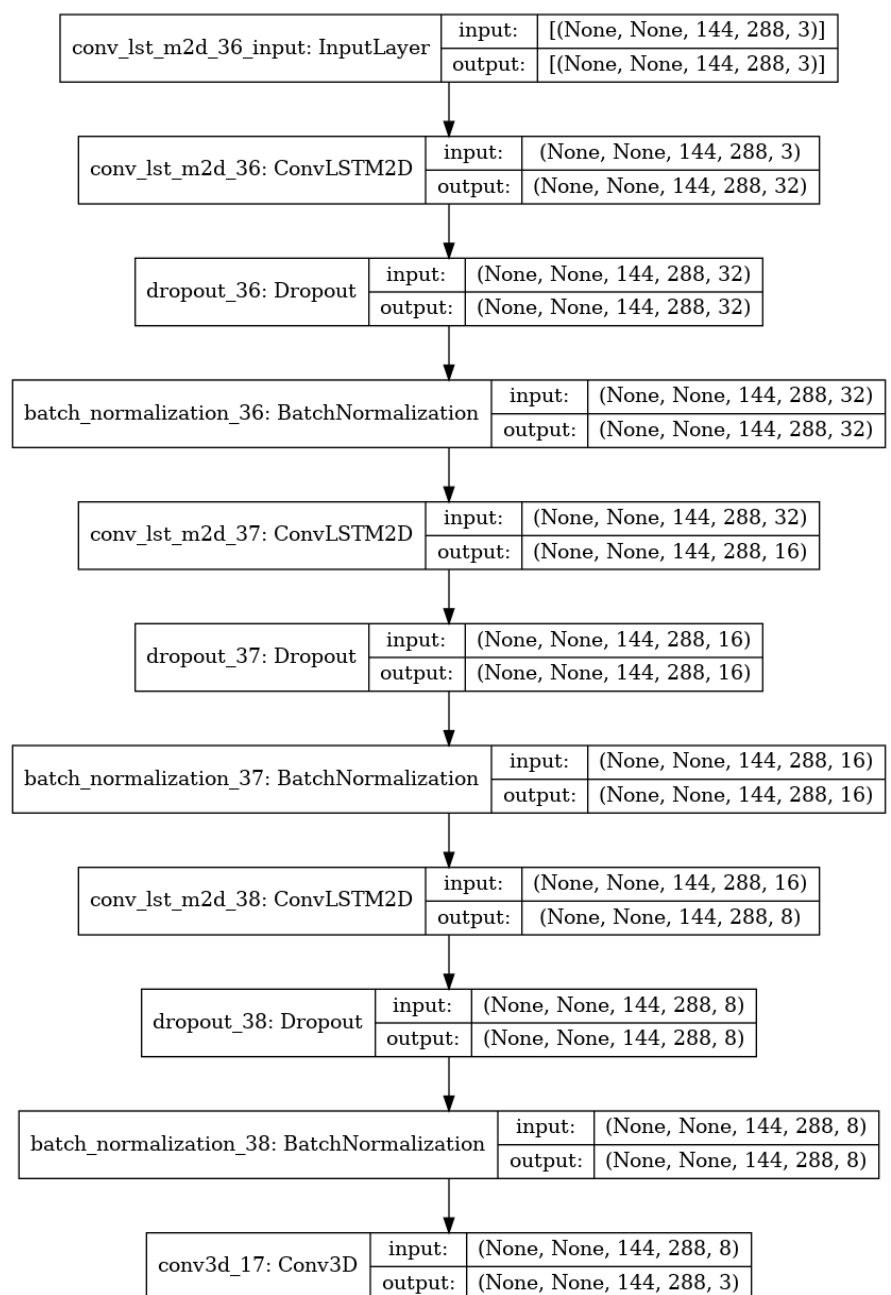
Figure 1. Plot of ConvLSTM developed model for sequence-to-sequence predictions.